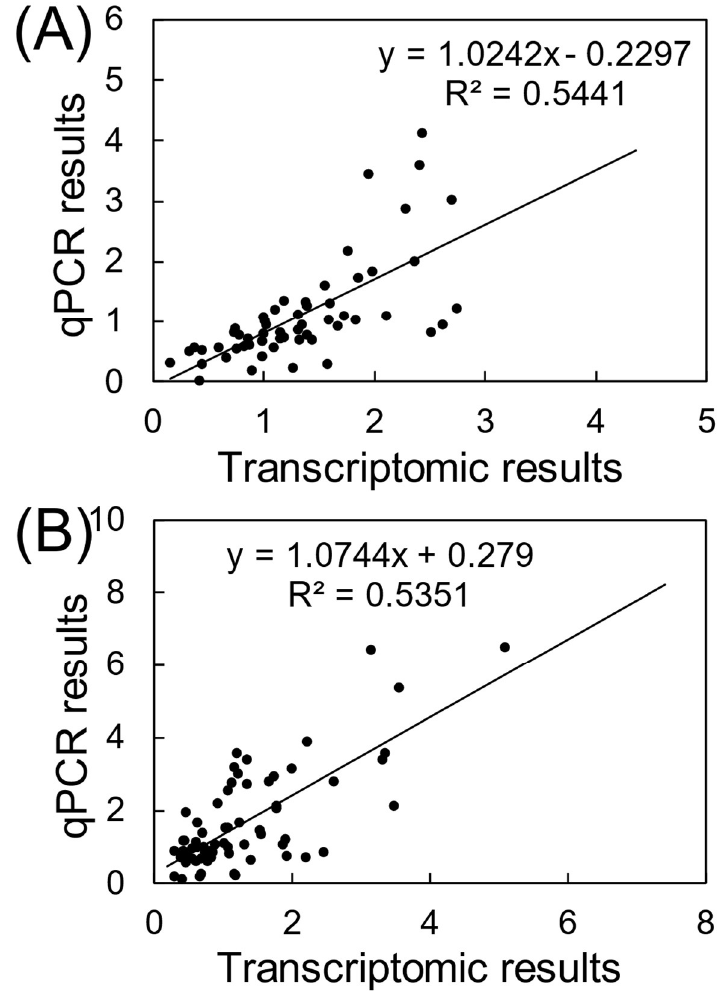
Figure 4. Correlation analysis between transcriptomic and qPCR results in male ( A ) and female ( B ) zebrafish.